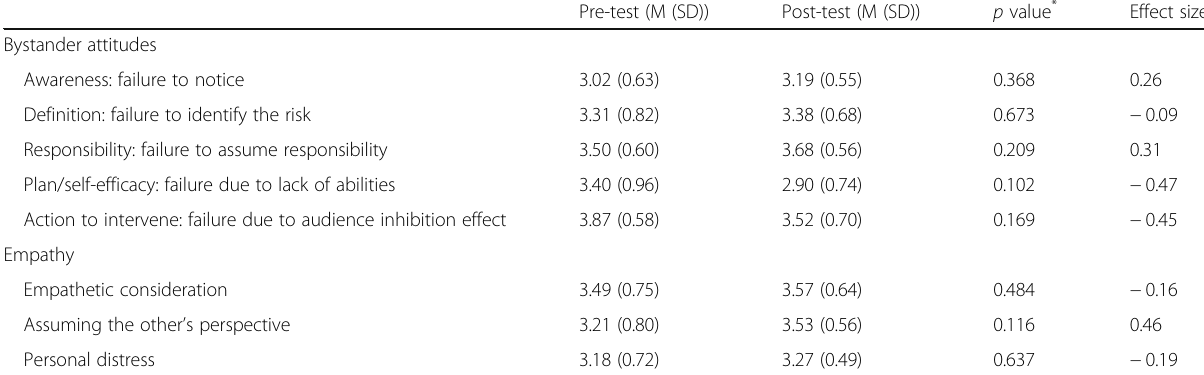
Table 4 ESPECTA-VN and empathy scale results before and after intervention for experimental group ( n = 14)